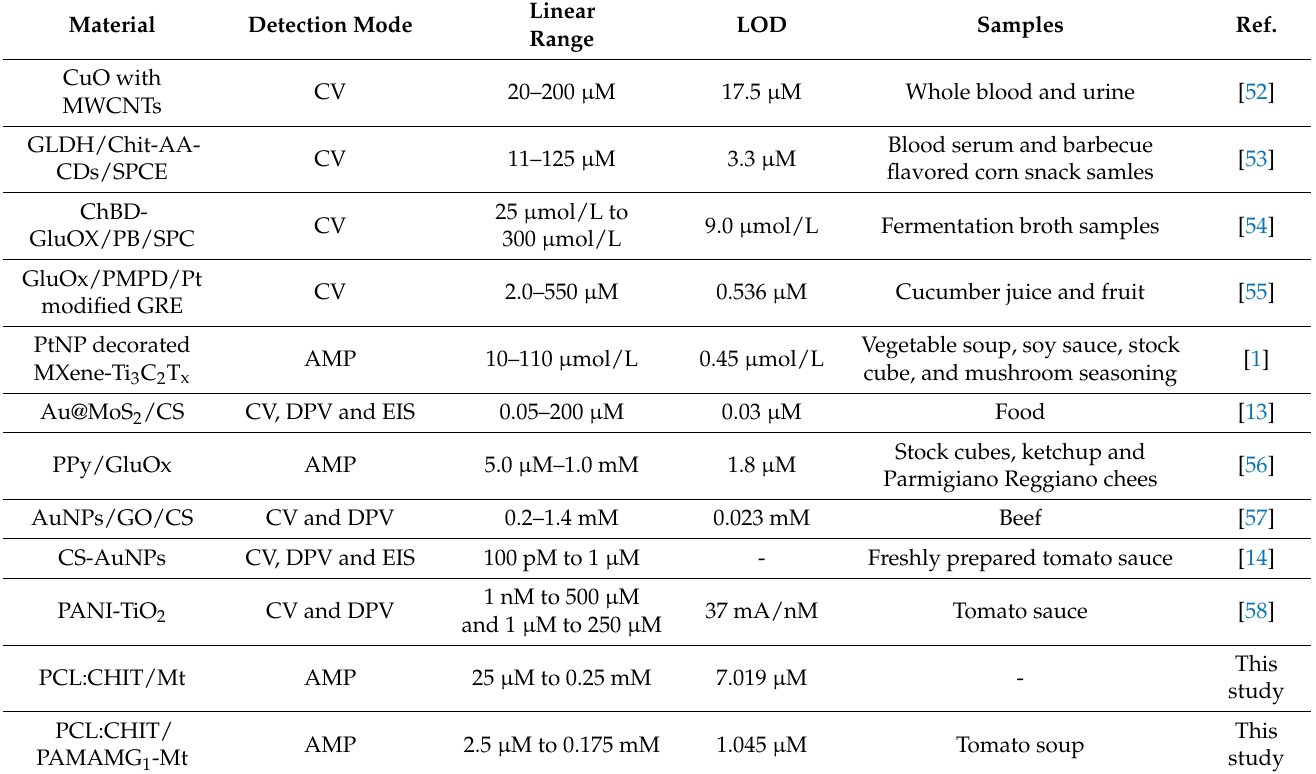
Table 1. A comparison of the performances of GluO x -based electrochemical biosensors in the